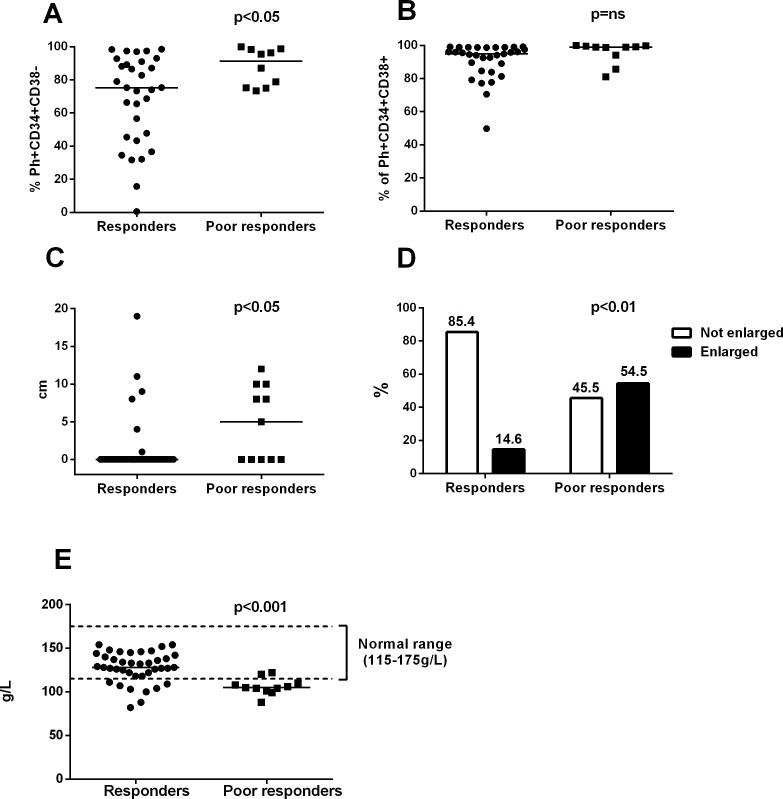
The poor responders have a higher percentage of Ph+CD34+CD38- cells and an enlarged spleen at diagnosis (dg).The proportion of Ph+ cells in the CD34+CD38- and CD34+CD38+ cell compartments was analyzed by sorting and FISH. A) The poor responders had a higher proportion of Ph+CD34+CD38- cells at dg when compared to the responder group (p<0.05). B) The proportion of Ph+CD34+CD38+ cells at dg. C) Difference in the size of the spleen (measured as the palpable part under the costal margin) between the poor responder and responder groups (p<0.05). D) Proportion of patients with enlarged spleen (pchi square <0.01). E) Hemoglobin levels in poor responders and responders. Statistical significance was analyzed with an unpaired two-tailed t-test, and median values are noted with lines. In panel D, the chi-square test was used.